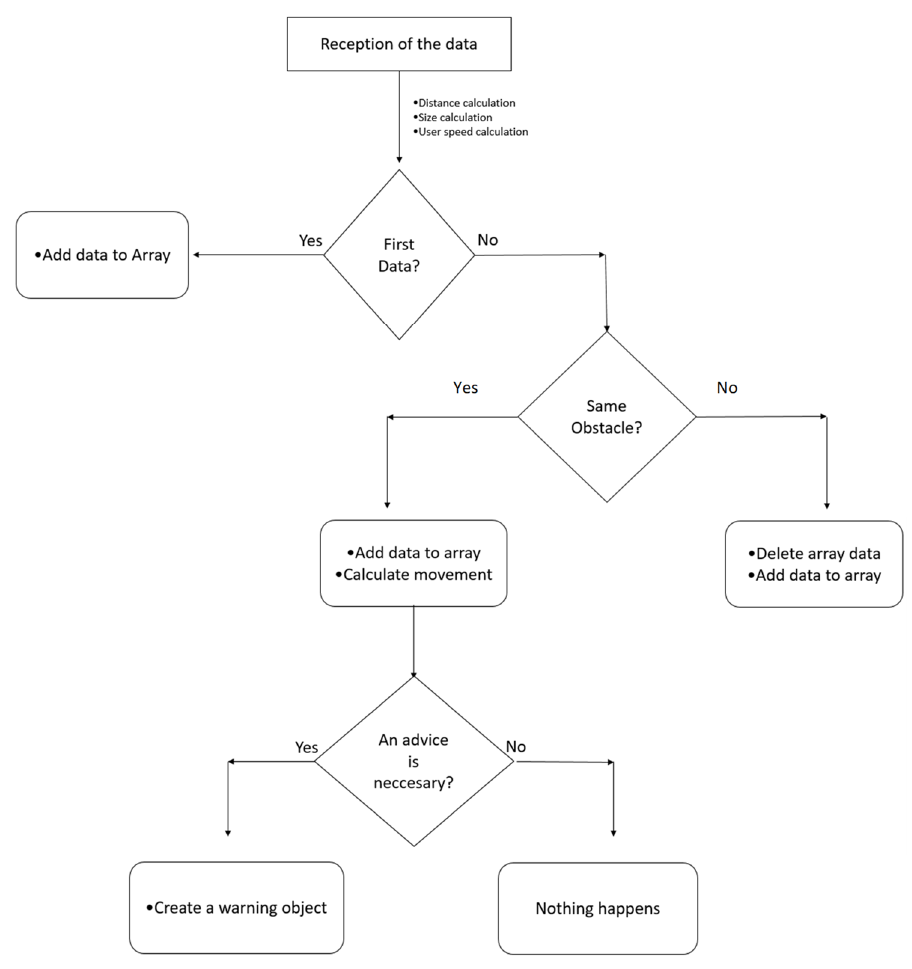
Figure 6. Flowchart of the proposed obstacle detection algorithm.